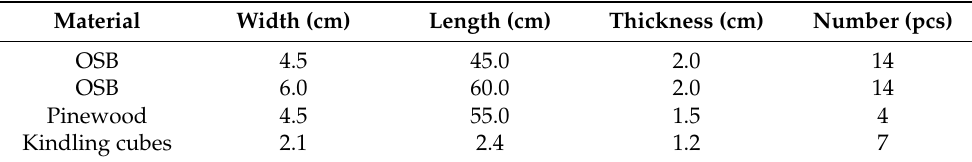
Table 4. Materials used for pile composition in the